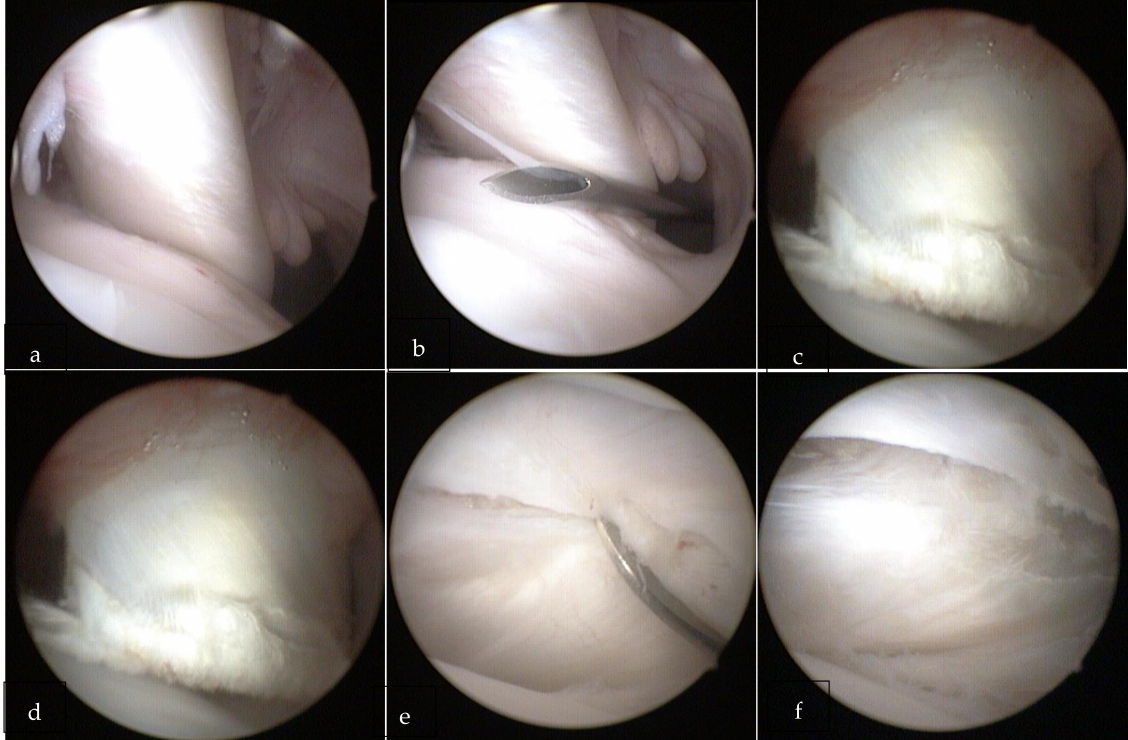
Figure 2. ( a ) Posterior view of the right shoulder showing the intact long head of the biceps tendon. ( b ) A standard anterior approach was established through a needle. ( c ) Tenotomy of the long head of the biceps tendon was performed. ( d ) Section of the anterior joint capsule was performed. ( e , f ) Section of the anterior joint